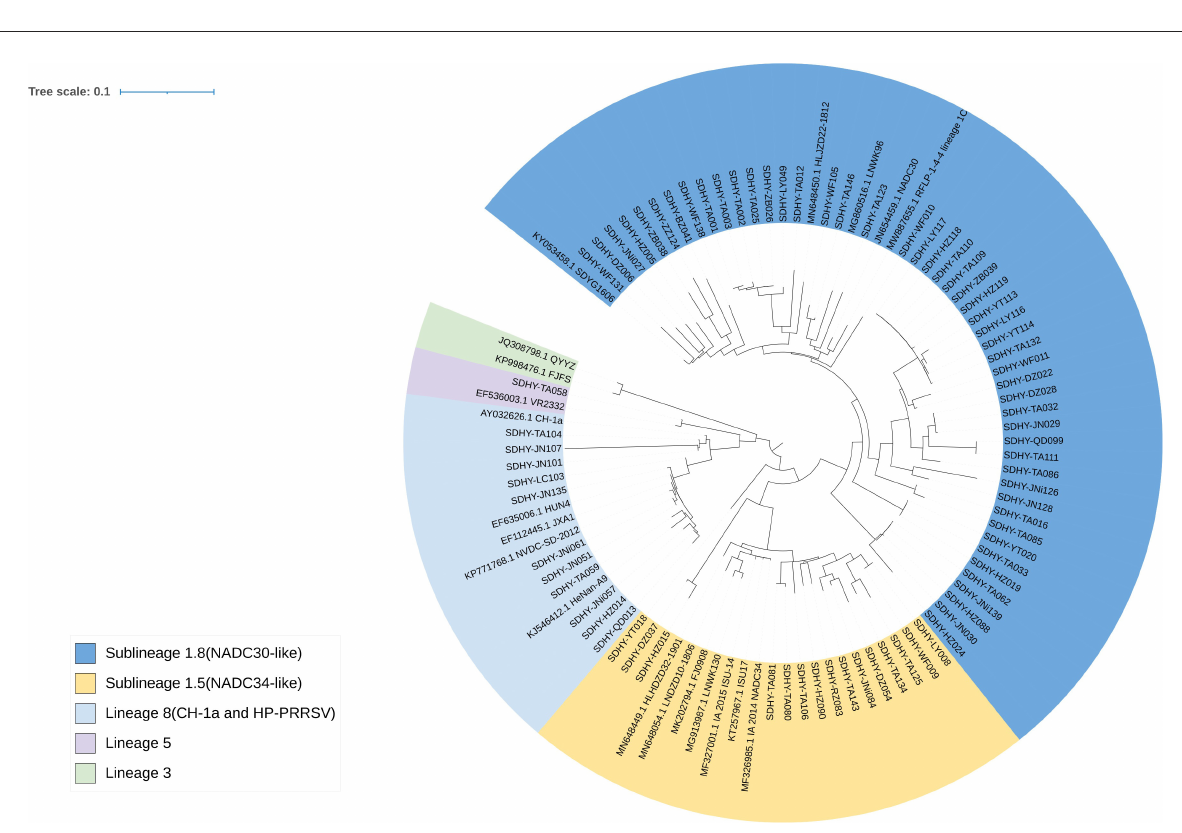
FIGURE3 Phylogenetic tree based on the PRRSV ORF5 sequence. Evolutionary analysis of maximum likelihood performed in MEGA X. Multiple sequence alignments generated using Clustal W. ITOL was used to modify the genetic evolutionary tree, using different colors to distinguish different lineages and reference strains with GenBank sequence